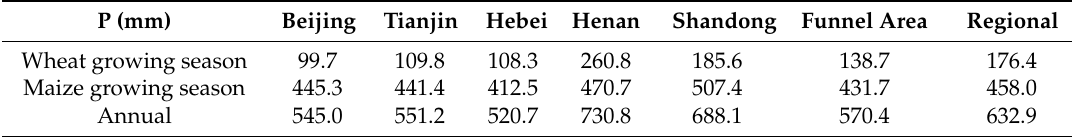
Figure 6. The spatial distribution of the long-term average precipitation (P) for ( a ) the winter-wheat growing season; ( b ) the summer-maize growing season and ( c ) the annual basis. Table 5. The province-wide, funnel area, and regional statistics for the wheat, maize, and annual average